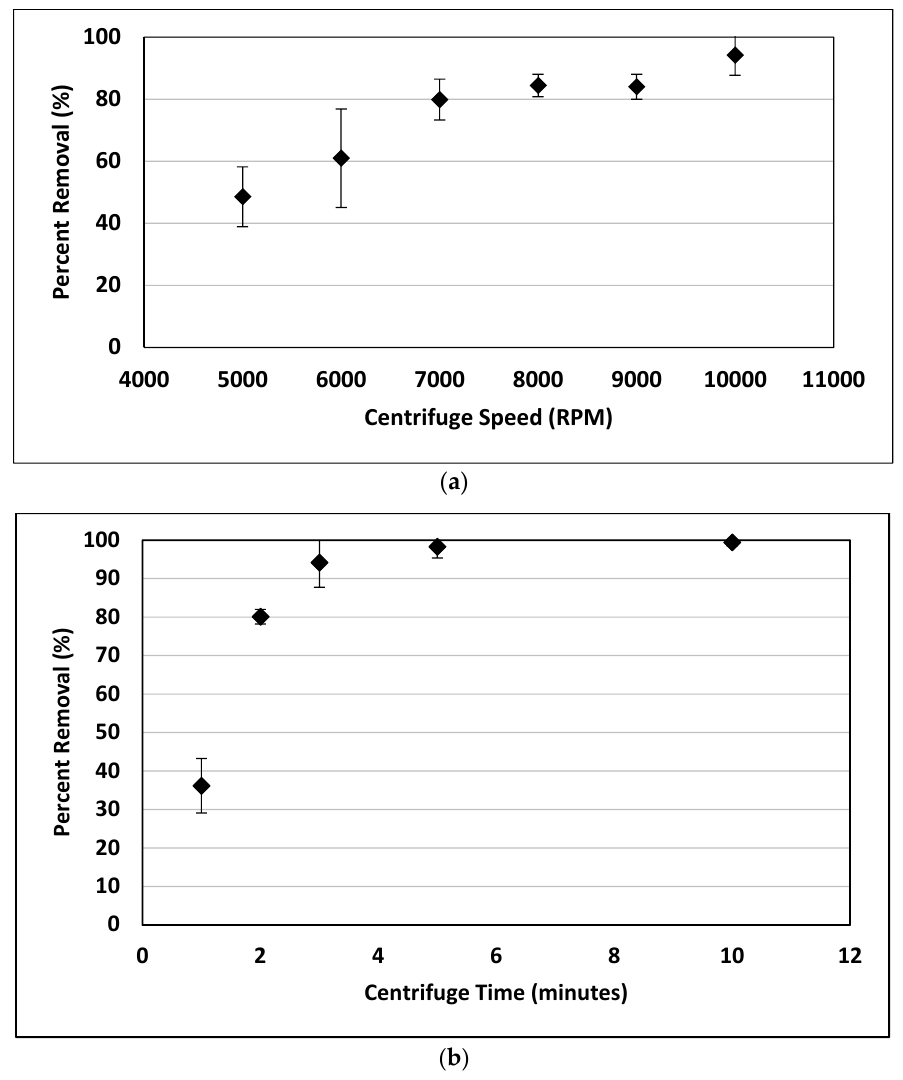
Figure 5. ( a ): Percent removal of nanoplastics by centrifugation at varying centrifuge speeds (time = 3 min) based on turbidity measurements. ( b ): Percent removal of nanoplastics by centrifugation at 10,000 RPM for varying centrifuge times based on turbidity measurements.